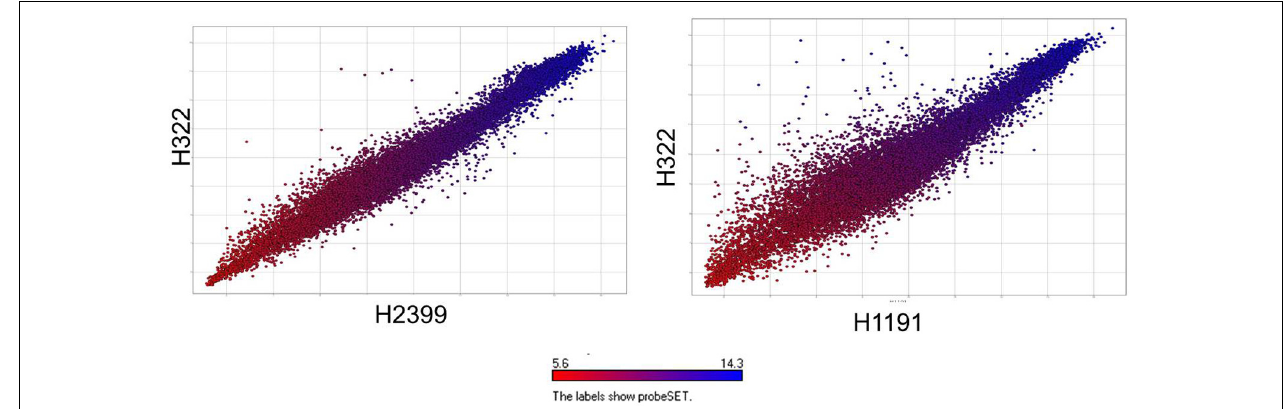
FIGURE 2 | Comparative microarray probe set summarization of two Swiss ST83 strains H2399 and H1191 compared to strain H322 using scatter plots showing RMA summarized probe set intensities from each strain’s data points which are color-coded based on their intensities in H322. The y -axis show the RMA summarized probe set intensities from H322 (blue) and the x -axis shows the probe set intensities from H2399 and H1191 (red),